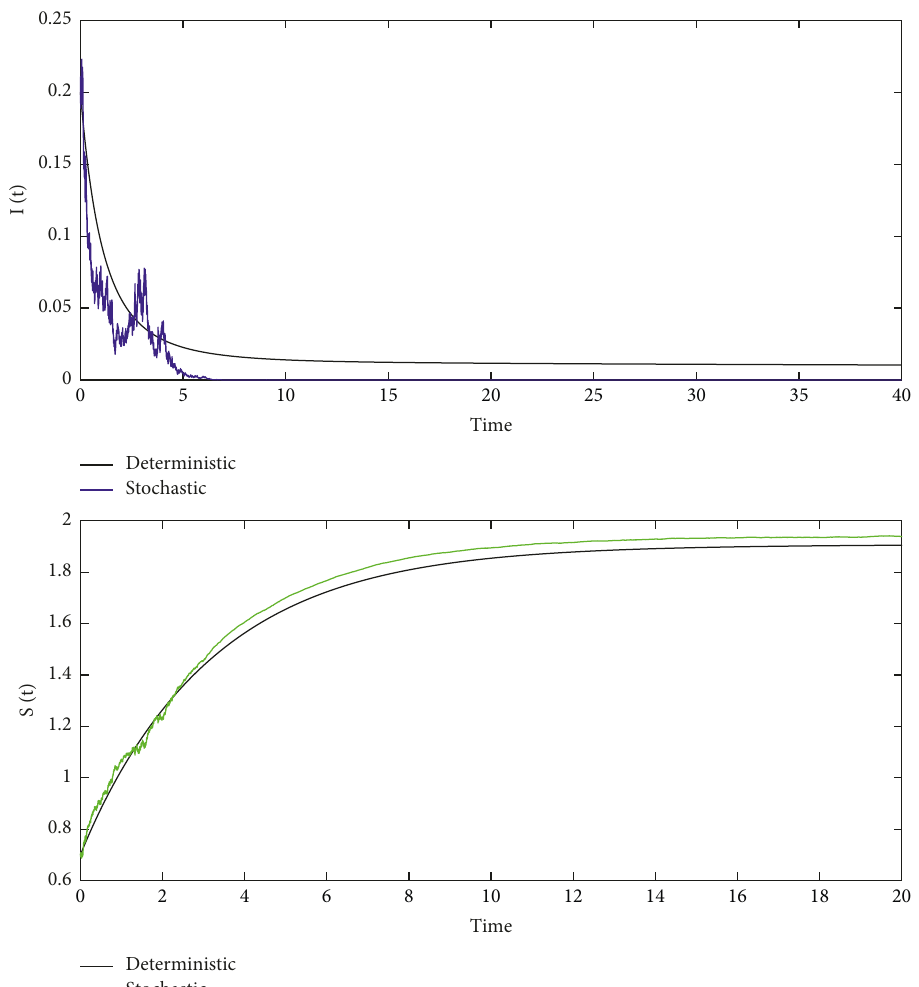
Figure 1: Comparison of the trajectory in stochastic system (3) ( I ( t ) : blue graph and S ( t ) : green graph) and deterministic system (1) ( I ( t ) : black graph and S ( t ) : black graph) for the extinction